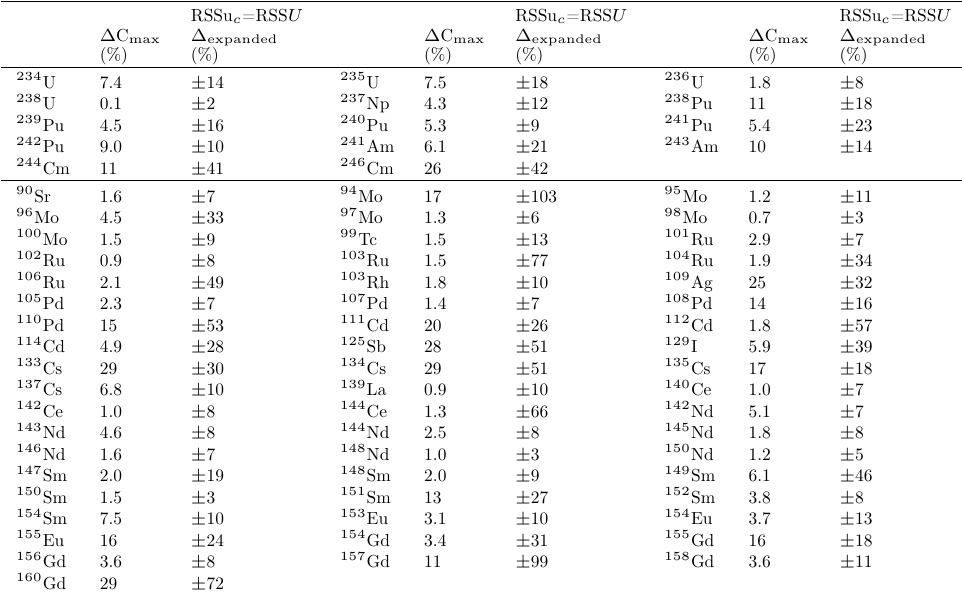
Table A.3. Expanded estimated uncertainties ∆ expanded (based on RSSu c ) for isotopic concentrations for the sample ENRESA-1, taking into account the calculation bias and the experimental and calculated uncertainties. ∆ C max come from the nuclear data library leading to the highest nuclear data uncertainty (either ENDF/B-VIII.0, JEFF-3.3 or